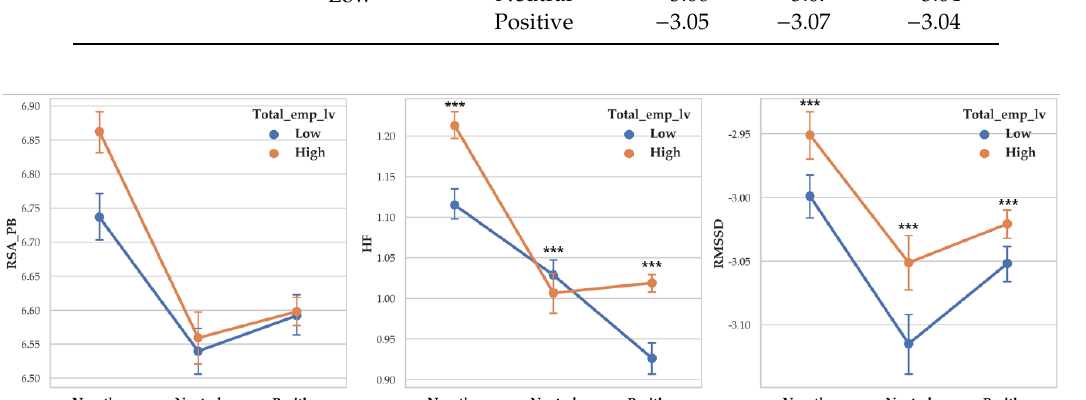
Figure 10. Point graph of vagal response depending on total empathy level when participant Figure10. empathized with valence. Total_emp_lv refers to total empathy level. Point means mean of vagal